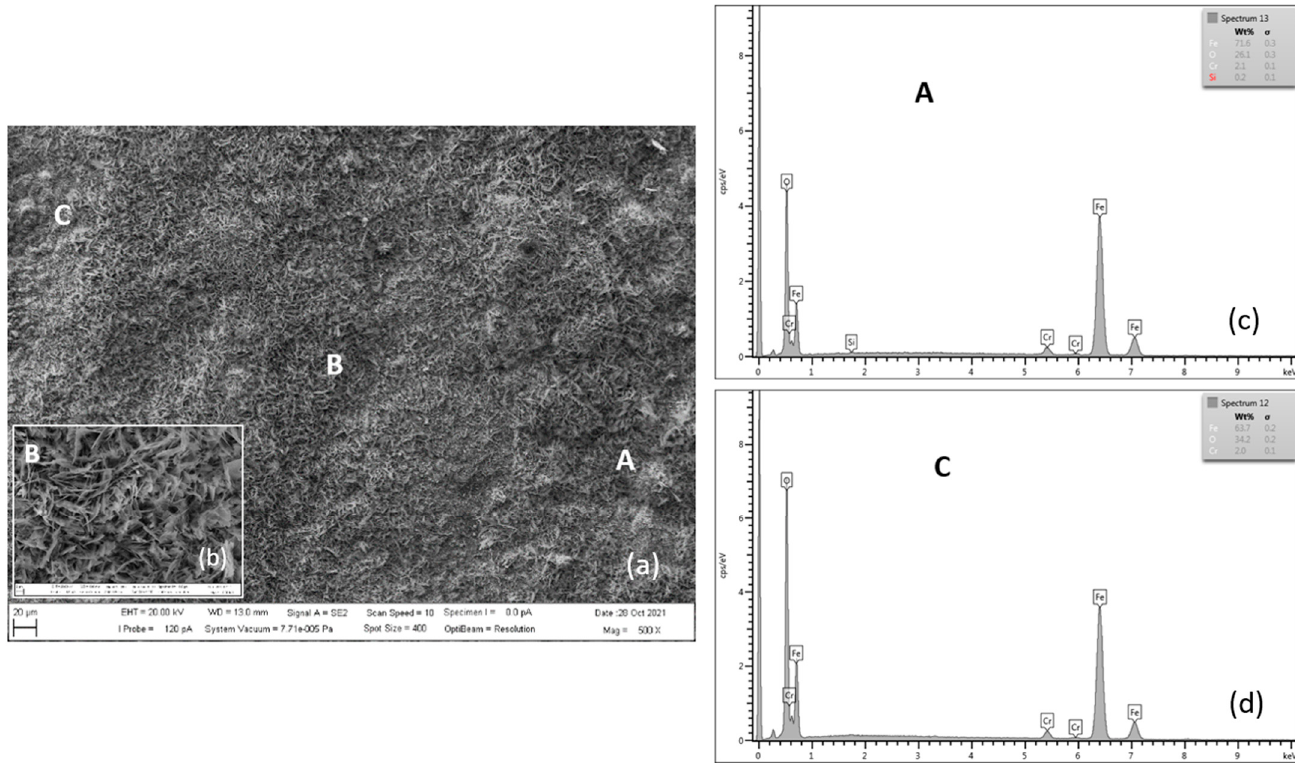
Figure 12. SEM morphology of the P91 steel surface layer oxidized for 3000 h at 600 °C ( a ), with B location detail ( b ), EDX energy spectrum of steel oxide surface ( c , d ). Table 7. Quantitative EDX analysis, sample P91 oxidized for 3000 h at 600 ◦ C (in wt.%).